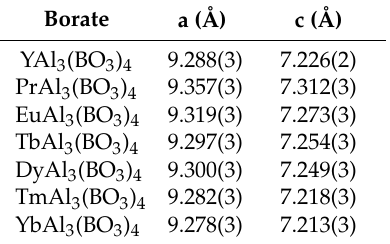
Table 1. Crystallographic characteristics of RAl 3 (BO 3 ) 4 (space group R 32) [1].